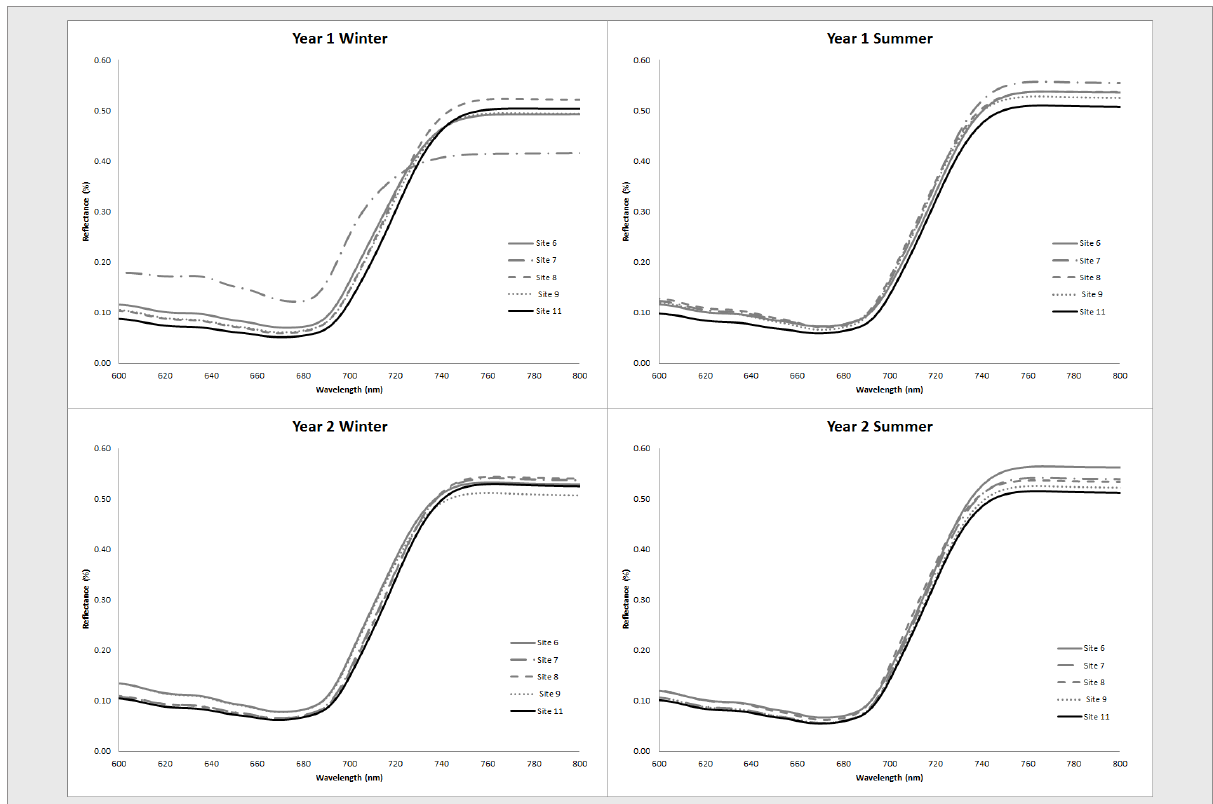
Figure 6: The chlorophyll red edge region for Sites 6–9 and 11. A blue shift in the red edge region of the Tweelopiespruit sites is visible, indicating lower chlorophyll levels. A higher reflectance in the near-infrared region is visible for the Tweelopiespruit sites in both seasons and years. The control site shows a red shift in the red edge region in both seasons and years, indicating higher chlorophyll levels. Control Site 11 shows a lower reflectance in the near-infrared region in the summer seasons of both